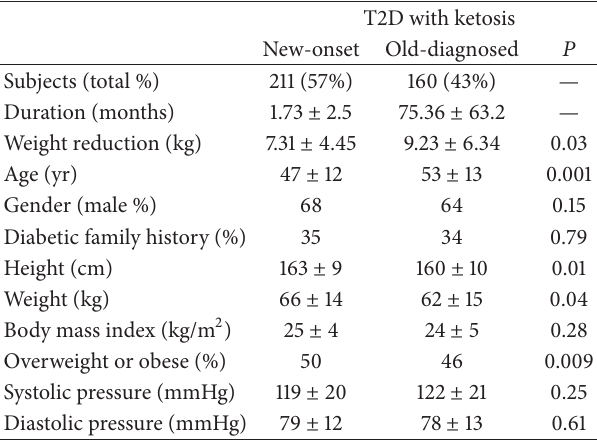
Table 1: Clinical characteristics of the new-onset and old-diagnosed T2D with ketosis patients.